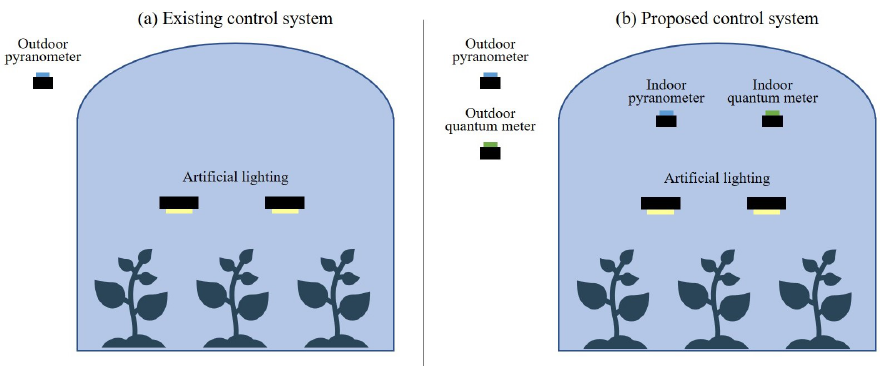
Figure 2. ( a ) The existing control open-loop including an outdoor sensor only. ( b ) The proposed control